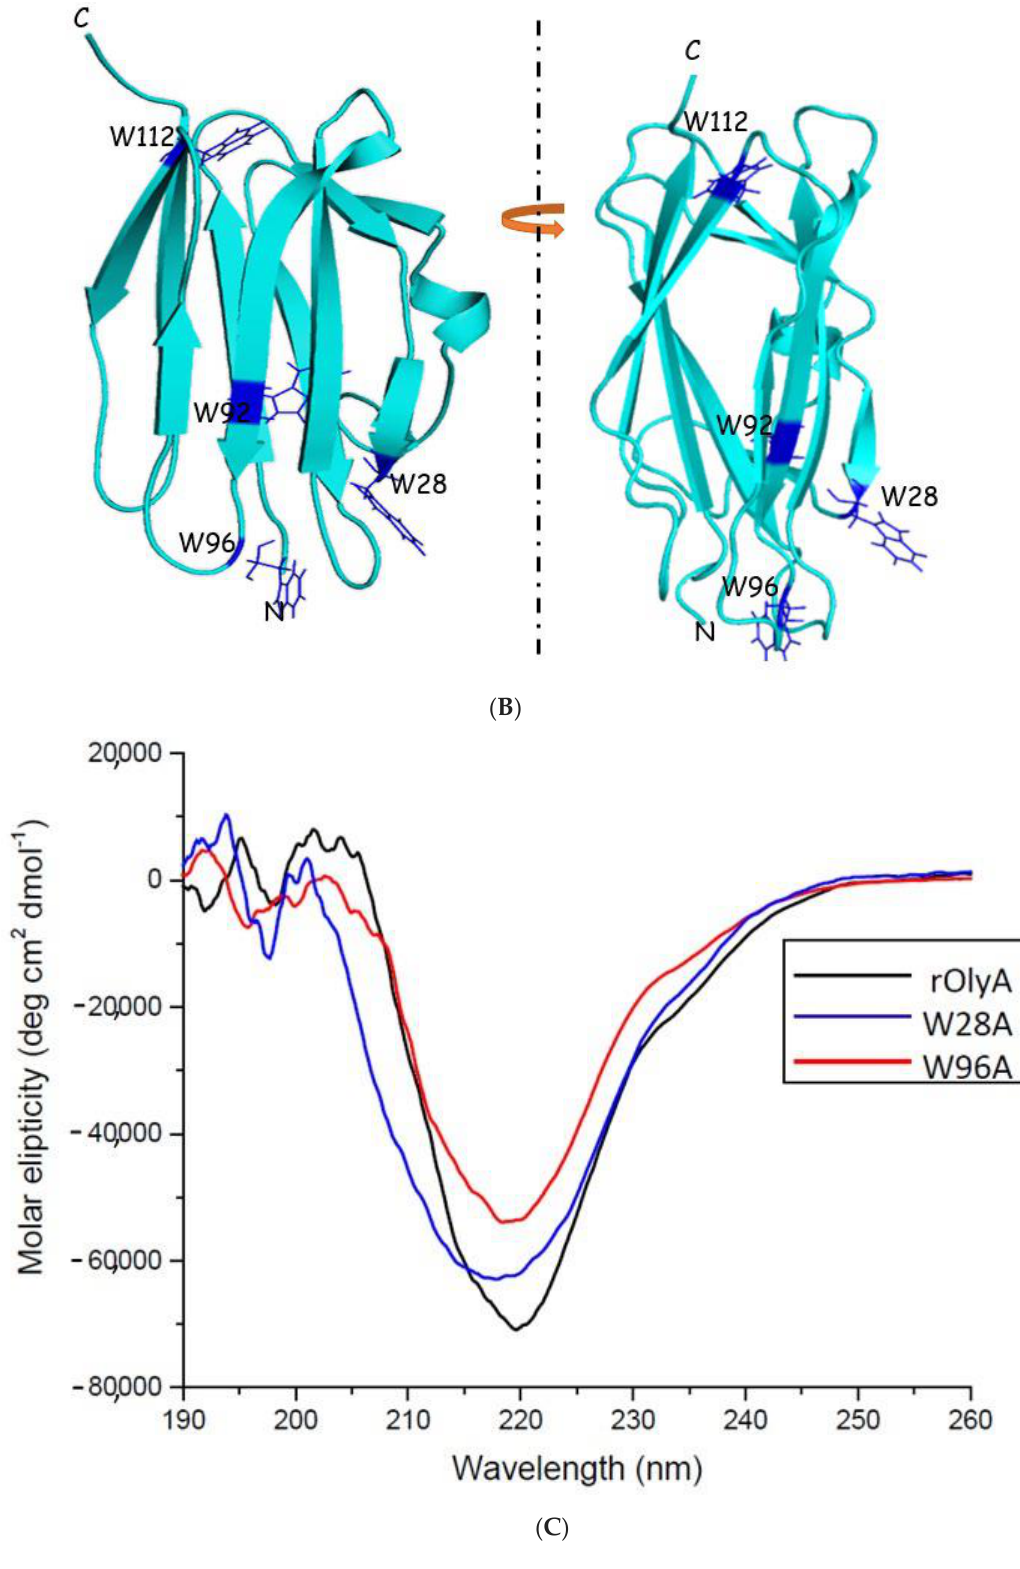
Figure 1. Conservation of aegerolysins and secondary structure analysis of rOlyA protein. ( A ) Alignment of the amino acid sequence (with CLUSTAL omega) of rOlyA and its homologous/orthologous proteins from the aegerolysin family. The family consists of recombinant ostreolysin A (rOlyA; GenBank entry KDQ25828) and five other members: OlyA6 (P83467), PlyA (Q8X1M9), OlyA (AAX21097), PlyA2 (BAN83906.1) and EryA (BAI45247.1). Strictly conserved residues are shown in black. Two cysteine residues were conserved in all five proteins (green). Six tryptophan residues were conserved (turquoise). Numbering is according to the rOlyA sequence. rOlyA and OlyA6 differed in only one amino acid substitution: rOlyA — isoleucine, OlyA6 — valine (red box). Abbreviations are as follows: EryA — erylysin A, OlyA — ostreolysinA ( Pleuratus ostreatus ), with high similarity to PlyA, protein from P. ostreatus and its ortholog, PlyA2, from P. eryngii ; rOlyA — recombinant OlyA in plasmid pTRC99A. ( B ) Cartoon representation of rOlyA model. Tryp- tophans for mutation are represented in blue. Positions of displayed residues as indicated. N — N- terminus; C — C-terminus. ( C ) CD spectra to estimate secondary protein structure of rOlyA, W28A and W96A demonstrate that the secondary structure of rOlyA and its mutants fits a β -sheet spec- trum, since the CD curve analyses are consistent. To estimate whether the secondary structure of rOlyA was affected by the introduc- tion of the point mutations (W28A, W96A), we analyzed the circular dichroism (CD) spec- tra of both point mutations and compared them to rOlyA CD spectra (Figure 1C). The CD spectra showed no significant changes in secondary structure for either point-mutated proteins, and the β -sheet structure appeared to be completely conserved (Figure 1C). 3.2. Contribution of Tryptophan Residues to the Biological Activity of rOlyA in HIB-1B Preadipocytes Our previous study in HIB-1B preadipocytes [2]( demonstrated that rOlyA (at 10 µg mL −1 ) induces striking morphological alterations consisting of the accumulation of struc- tures resembling lipid droplets. However, the W28A and W96A mutants did not induce